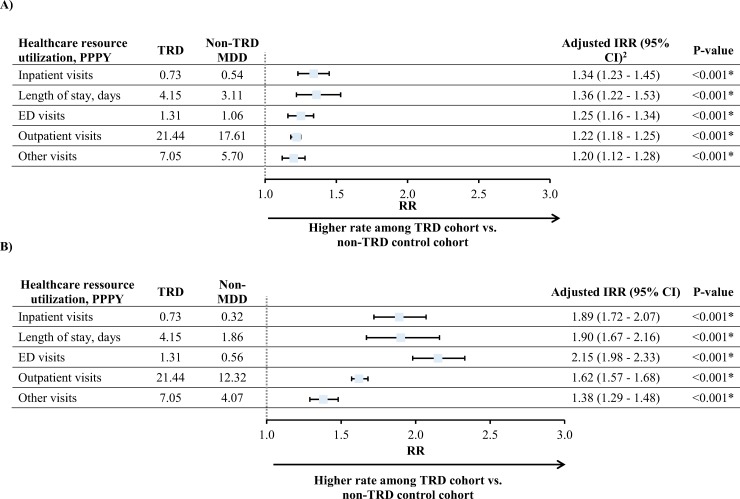
All-cause HRU per-patient-per-year (main analysis)a.A)TRD versus non-TRD MDD. B) TRD versus non-MDD. Abbreviations: CI = confidence interval; IRR = incidence rate ratio; MDD = major depressive disorder; PPPY = per patient per year. Notes: [1] HRU was measured from the index date up to two years post-index date. [2] Adjusted for baseline total healthcare costs and Quan-CCI.